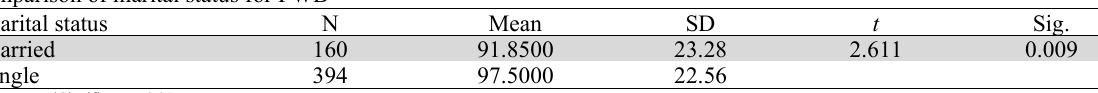
Comparison of marital status for FWB